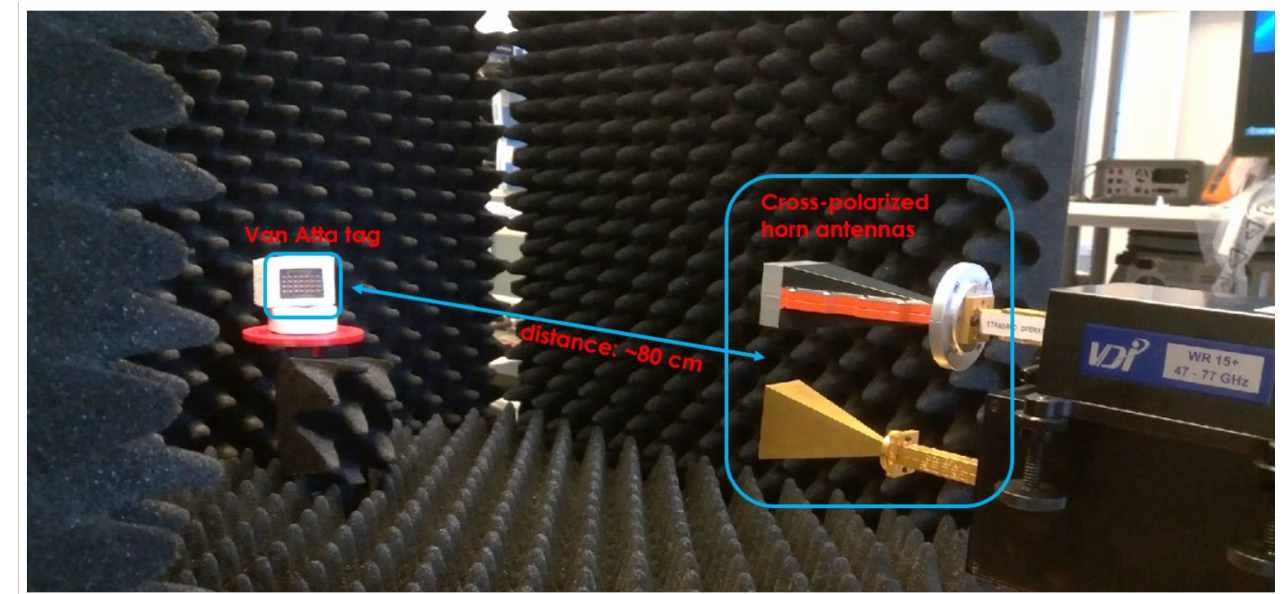
Figure 6. The measurement setup in the anechoic chamber.